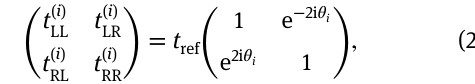
of 0.5/1.5 to the g values [50–52] while the principle 2 and mechanism of coincidence imaging remain the